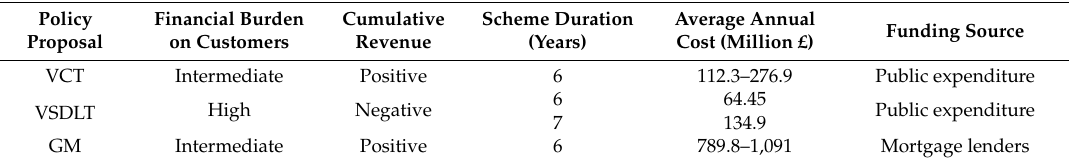
Table 8. Summary of consumer financial burden, systemic costs of deployment, and funding sources of policy